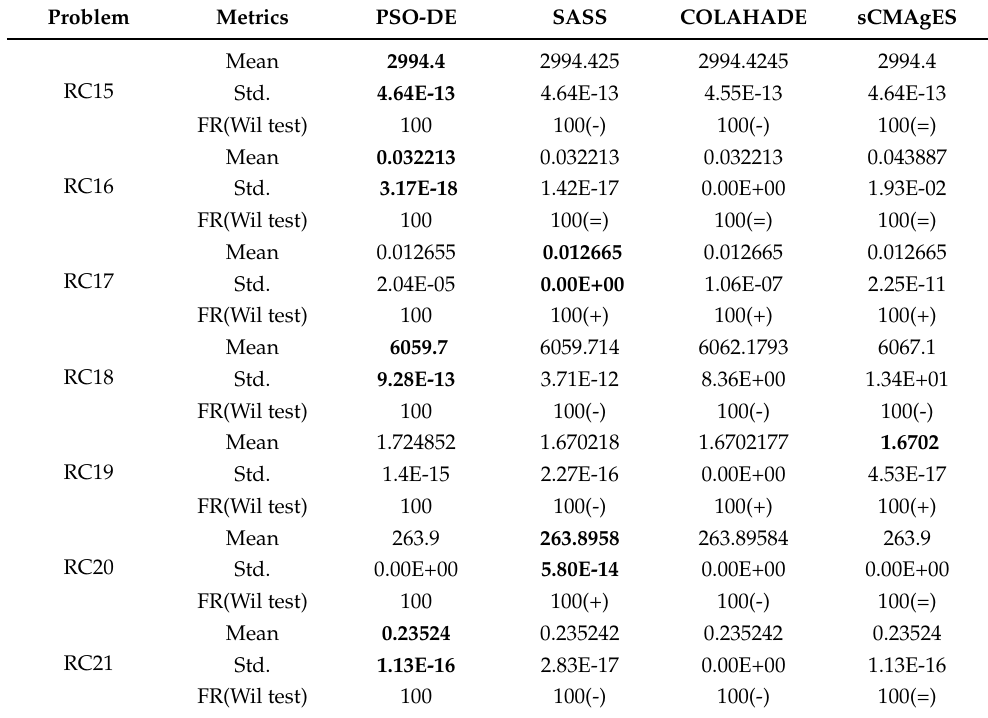
Table 10. Experimental results of